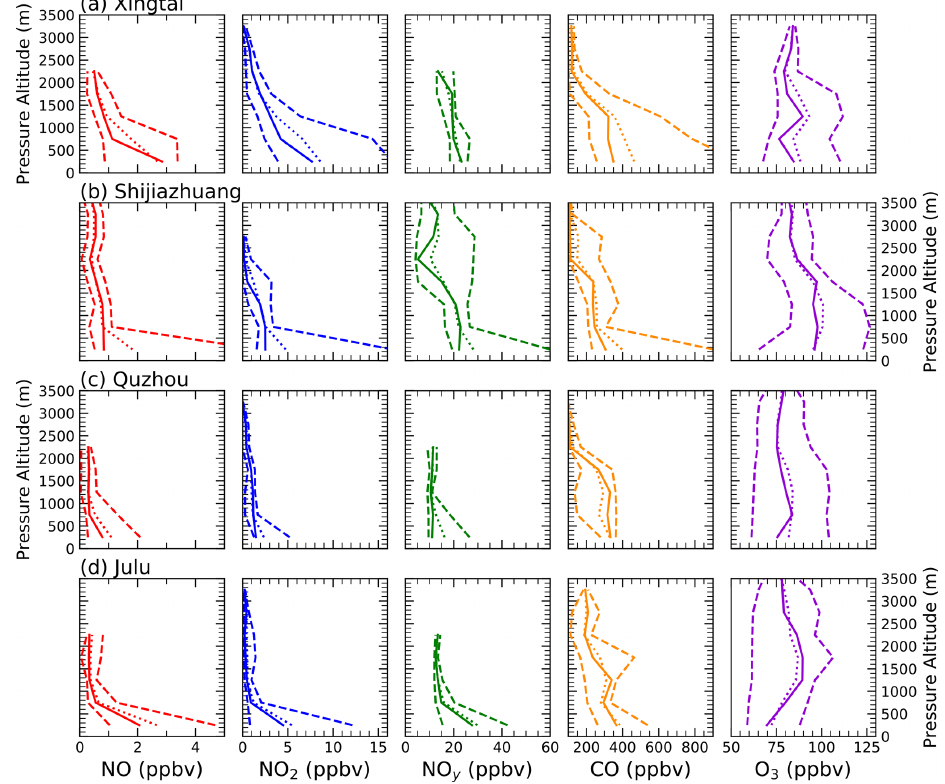
Figure 4. Vertical profiles of 1s NO (red), NO 2 (blue), NO y (green), CO (orange), and O 3 (purple) in 500m bins over the four spiral locations: Xingtai (a) , Shijiazhuang (b) , Quzhou (c) , and Julu (d) . The dashed lines indicate the 10th and 90th percentiles, the solid line is the median, and the dotted line is the mean. We remove observations of NO / NO y above 2500m over three spiral locations due to limited